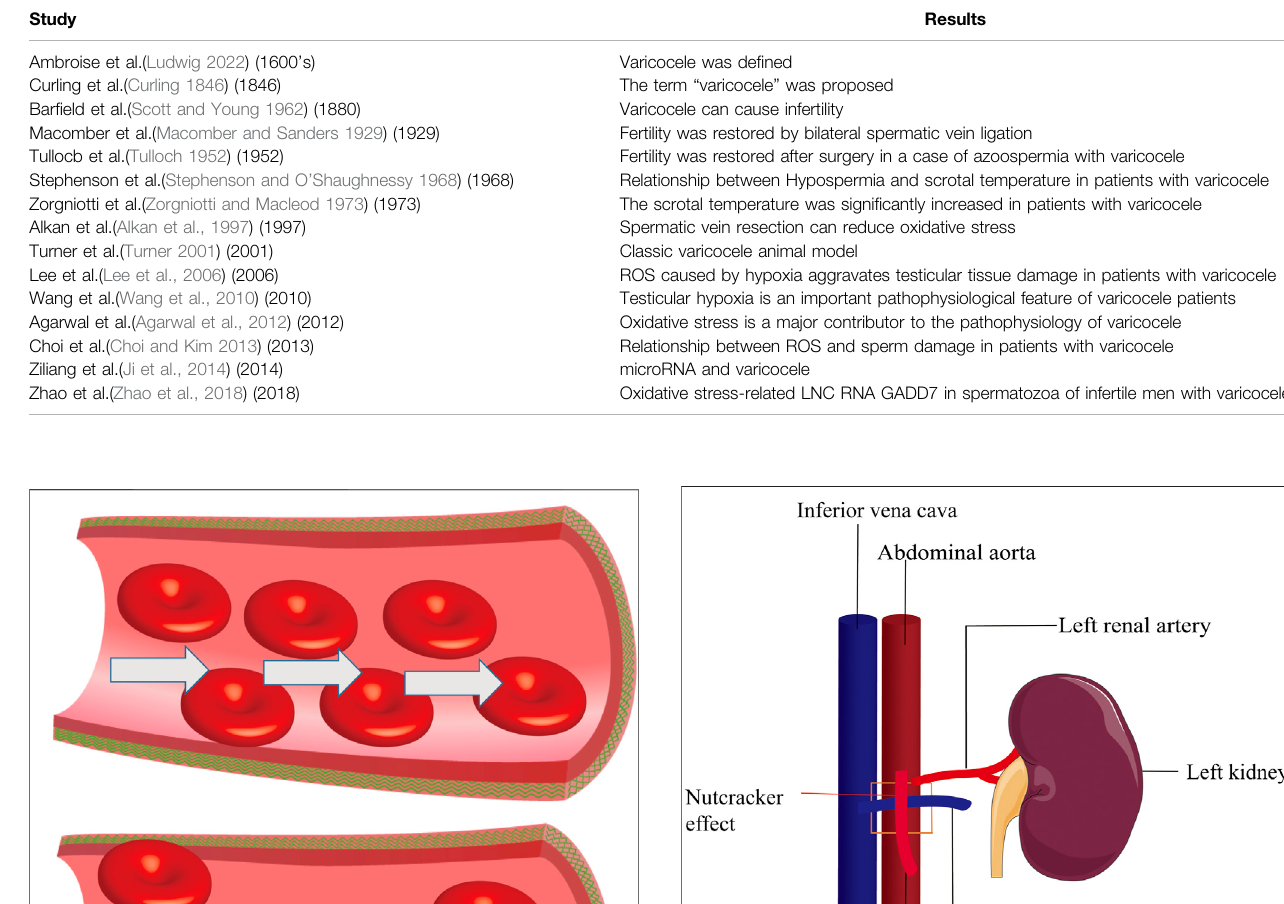
TABLE 1 | The history of the development of varicocele.